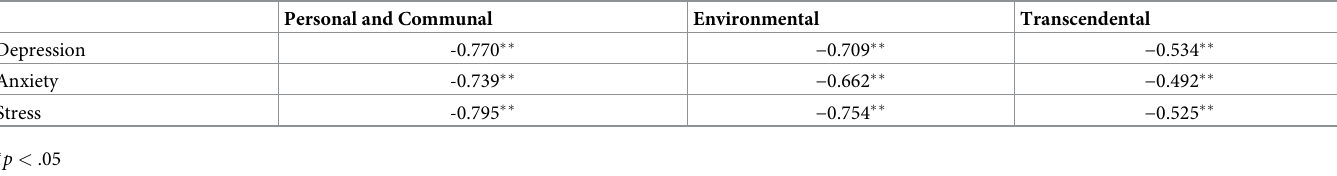
Table 4. Pearson correlations between three domains of spiritual wellbeing and three types of psychological disorder among undergraduate students (N = 500).